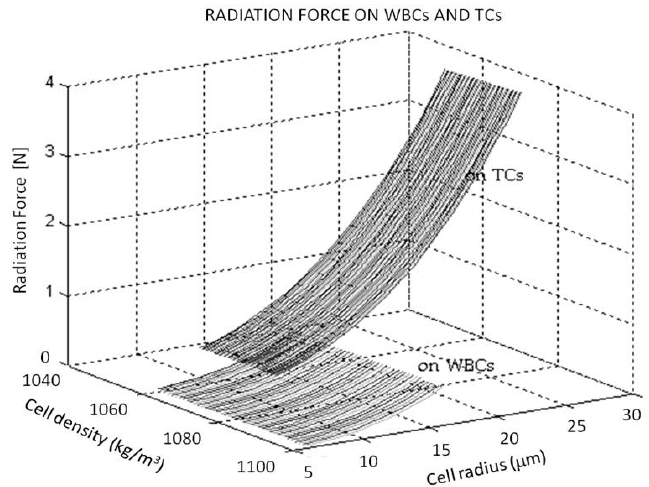
Figure 1. Estimate of the radiation force exerted on WBCs and TCs, respectively, at the same acoustic acoustic conditions.